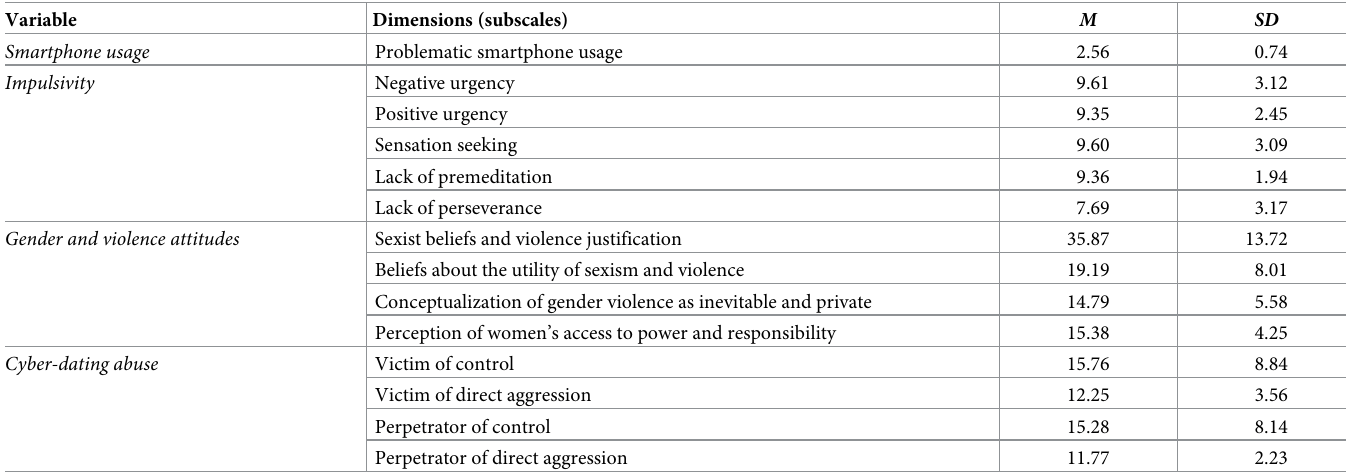
Table 1. Descriptive statistics for the dimensions of each variable of